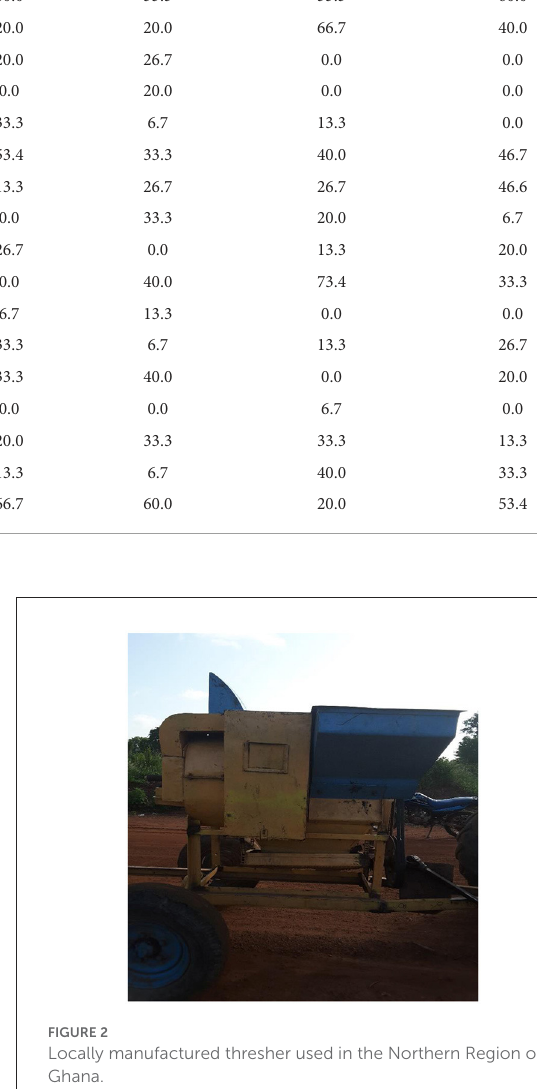
Farmers sold the grain as and when they are in need of income. Not < 93% of farmers in all the regions used sun drying (Table 6). Farmers use sun drying because the